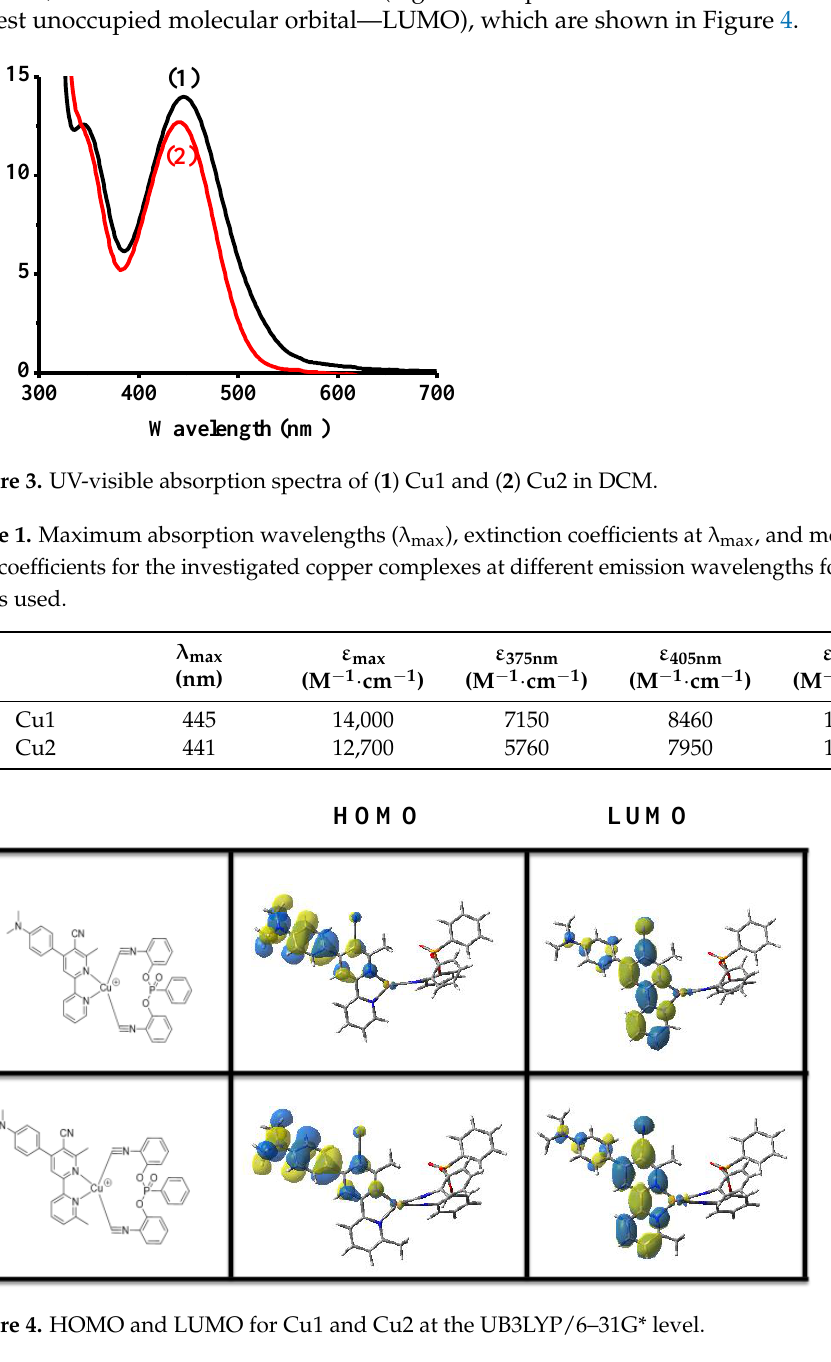
Figure 4. HOMO and LUMO for Cu1 and Cu2 at the UB3LYP/6 – 31G* level.